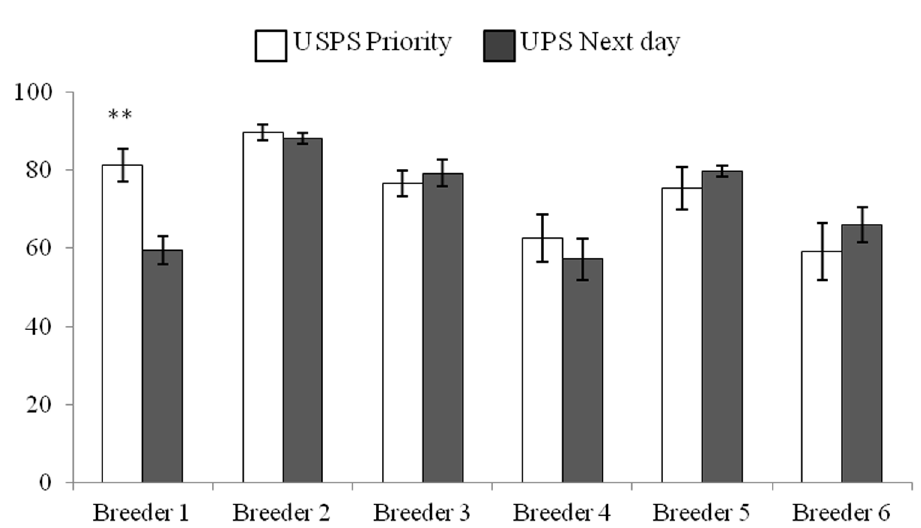
Fig 2. Sperm viability in queens heading colonies that were rated as in healthy or failing health. Queens are from two commercial beekeeping operations, colony heath was rated by the beekeeper and sperm viability assessments conducted blind relative to hive ratings. Data are from queens removed from a single apiary in either the east coast (healthy n = 8 and failing n = 14) or west coast (healthy n = 9 and failing n = 12) and asterisk indicate significant differences in viability within apiaries (paired t-test P < 0.05).